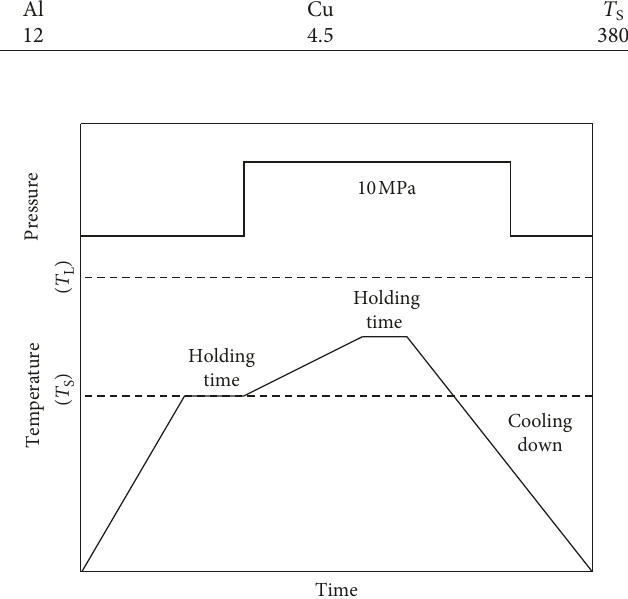
Figure 1: Schematic diagram of the brazing